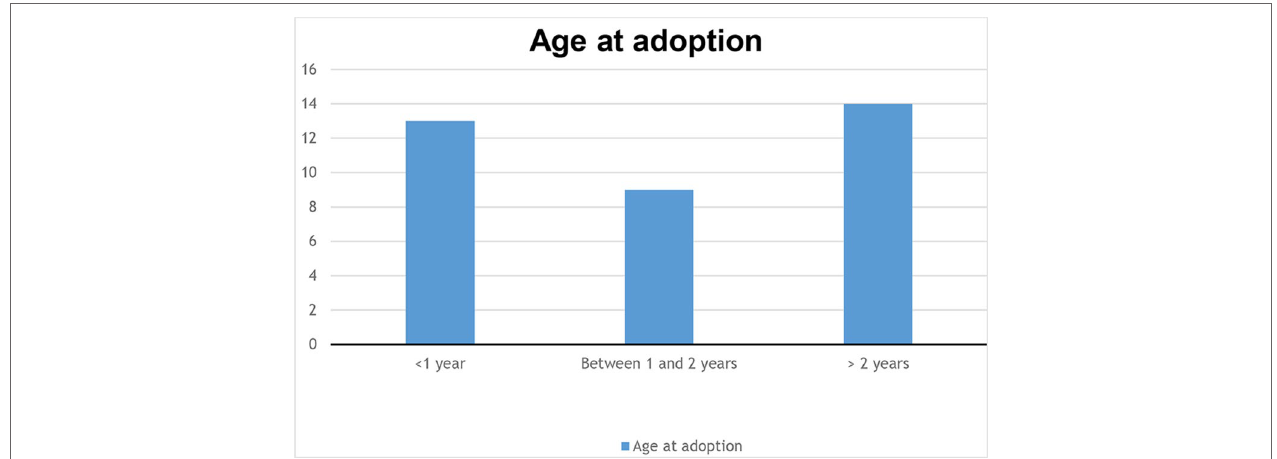
FIgURE 3 | Age at